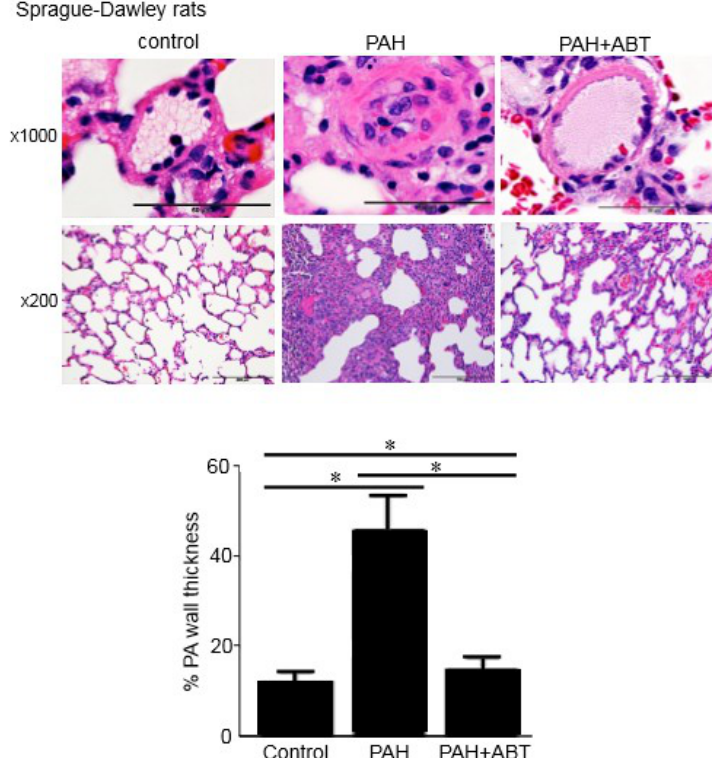
Figure 5. ABT-263 reverses pulmonary artery (PA) remodeling in Sprague-Dawley rats treated with SU5416/hypoxia. Sprague-Dawley rats were treated with SU5416, subjected to sustained hypoxia for three weeks, and then maintained in normoxia for five weeks. After pulmonary vascular remodeling was developed, ABT-263 (5 mg/kg body weight) was then injected four times over a two-week period. Lung tissues were immersed in buffered 10% formalin and embedded in paraffin for haematoxylin and eosin (H&E) staining. Representative images at × 1000 and × 200 magnifications are shown. The bar graph represents means ± SEM of % PA wall thickness (n = 5). * denotes that the values were significantly different from each other at p < 0.05.